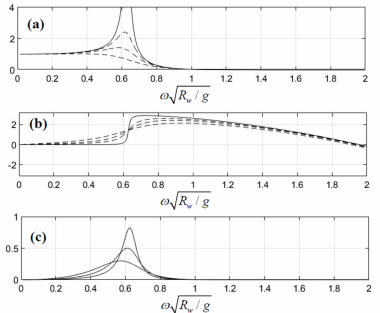
Figure 10. Calculated results by the present method concerning the responses of single heaving WEC of Figure 8 for various values of the B PTO = [20 10 5] B 33,av , and B PTO = 0. ( a ) Modulus and ( b ) phase of heave response (RAO), where the case of freely floating body ( B PTO = 0 ) is indicated by using solid lines. ( c ) Calculated performance index P